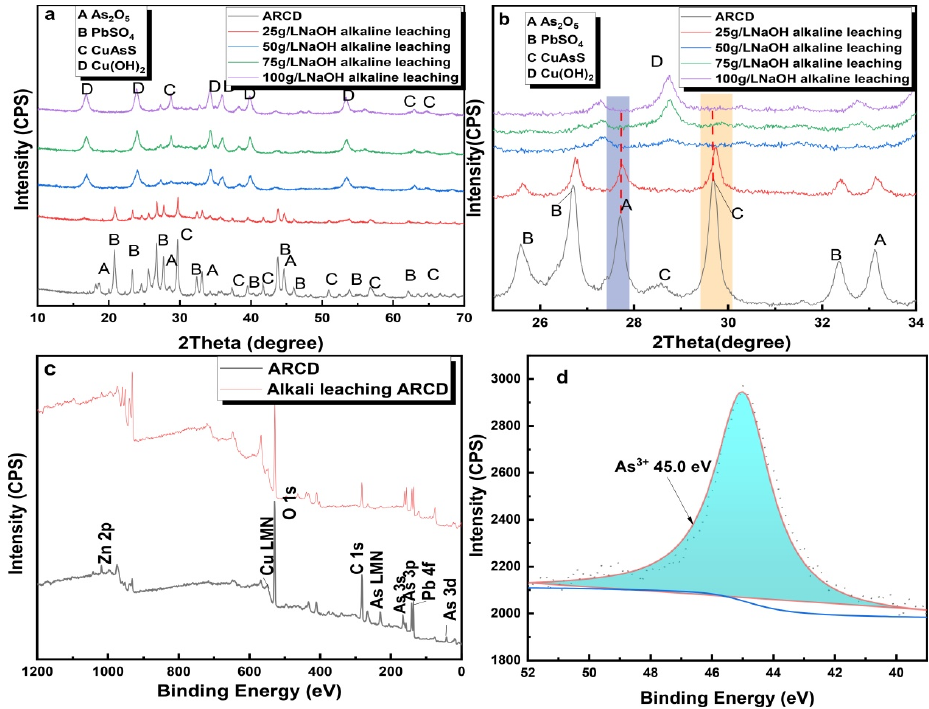
Figure 5. ( a , b ) XRD pattern, ( c ) XPS spectra, full spectrum, ( d ) As 3d of the alkaline leaching residue.